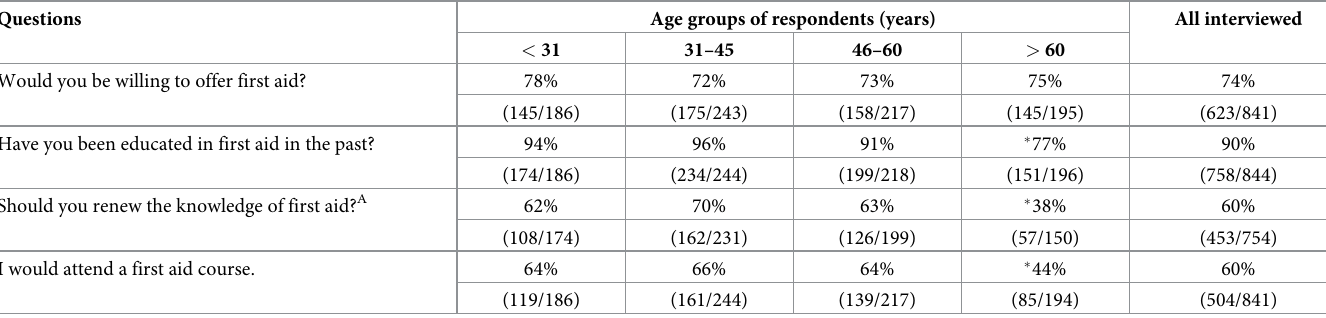
Table 4. Willingness to give first aid to the injured person and interest in renewing knowledge of first aid